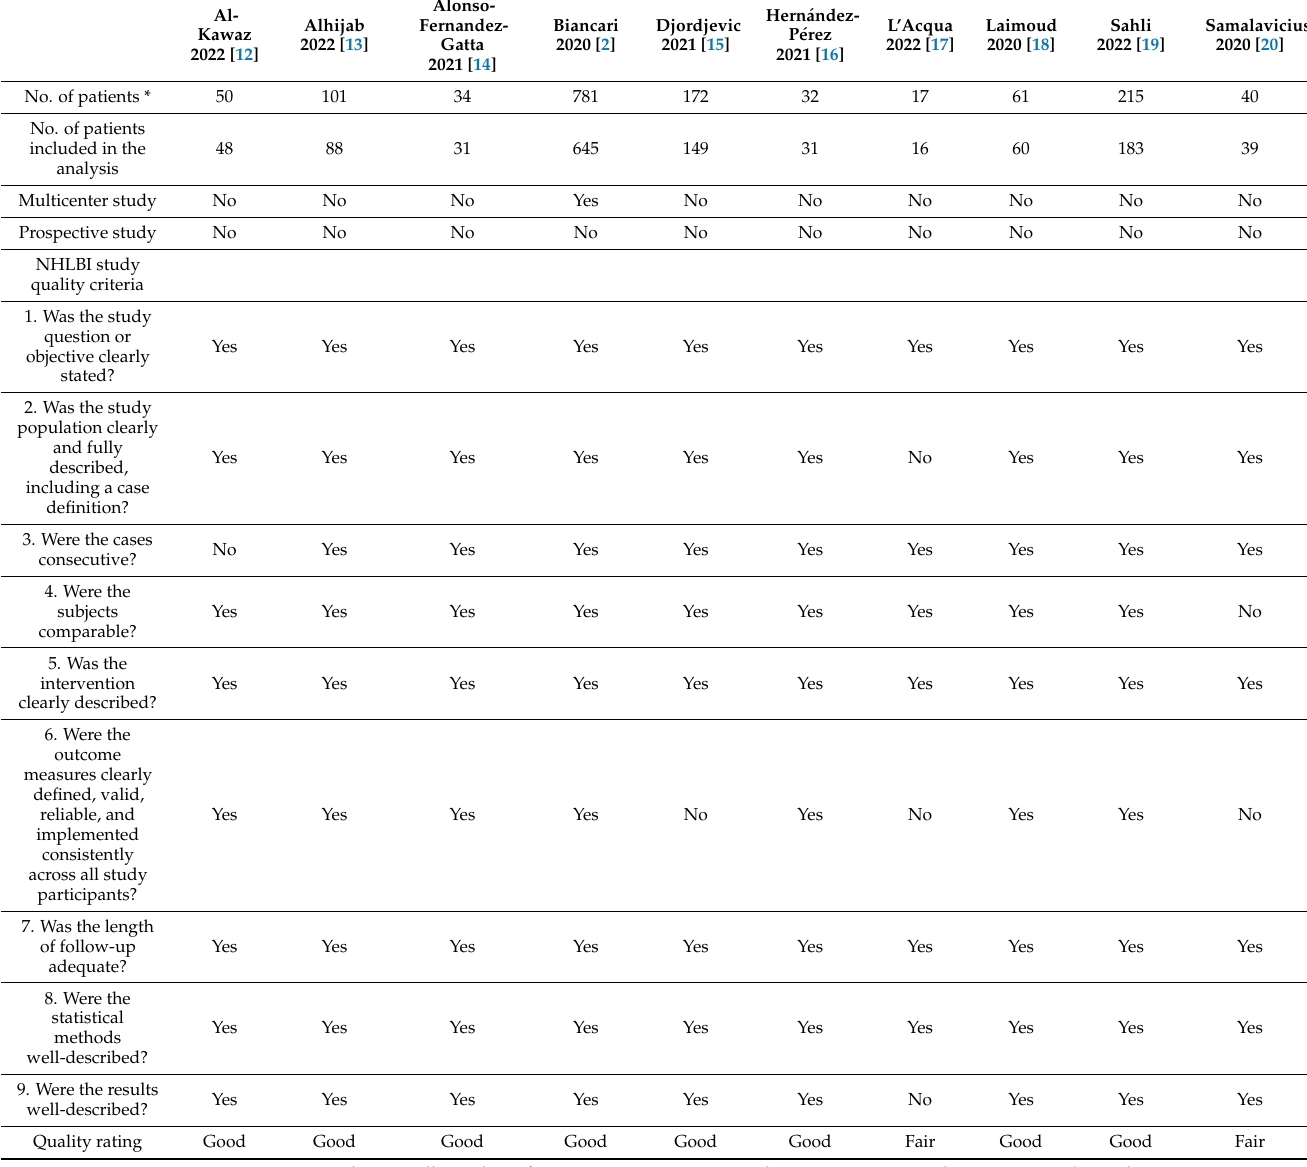
Table 2. Characteristics and quality of studies included in the present individual patient data meta- analysis according to the National Heart, Lung, and Blood Institute Study Quality Assessment Tools for case series